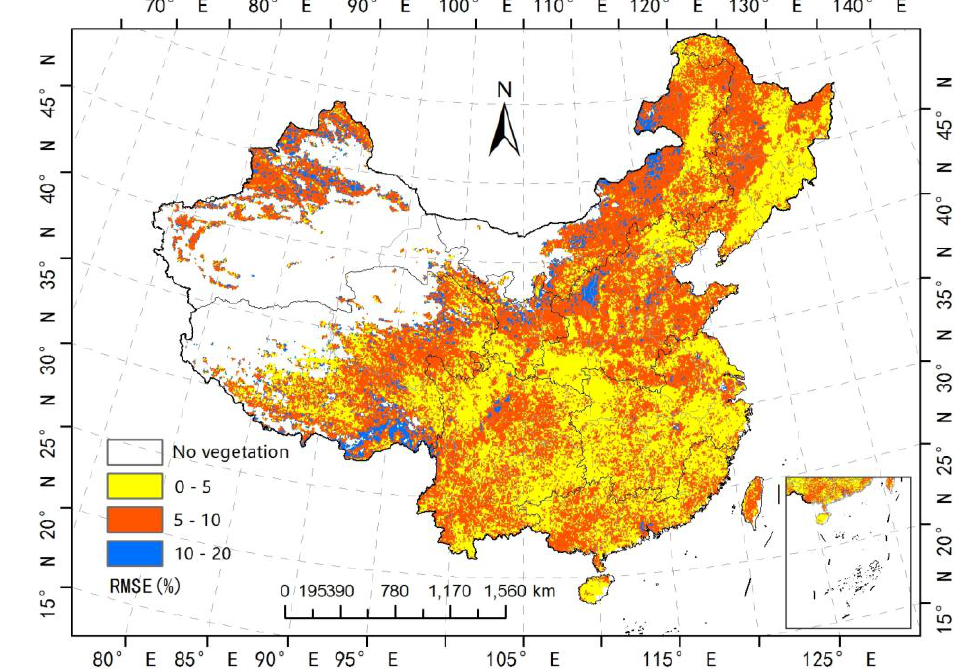
Figure 5. Spatial distribution of Root Mean Square Error (RMSE) in multiple linear regression